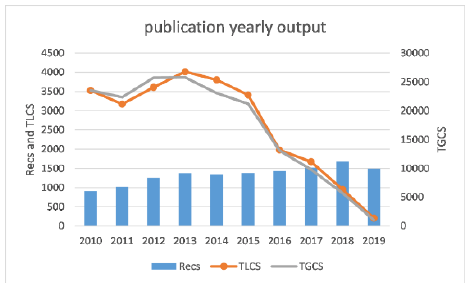
Figure 1. The number of papers published each year (where TLCS represents the values quoted within the dataset, representing the recognition within the domain, TGCS represents the value referenced by the entire Web of Science database, representing the recognition by all-science community) From Figure 1, it can be seen that the TLCS has a local peak in 2013, which means that the work in 2013 has gained a great in- domain attention. It is worth noting that although the TLCS and TGCS are relatively low in the past three years, it is not that